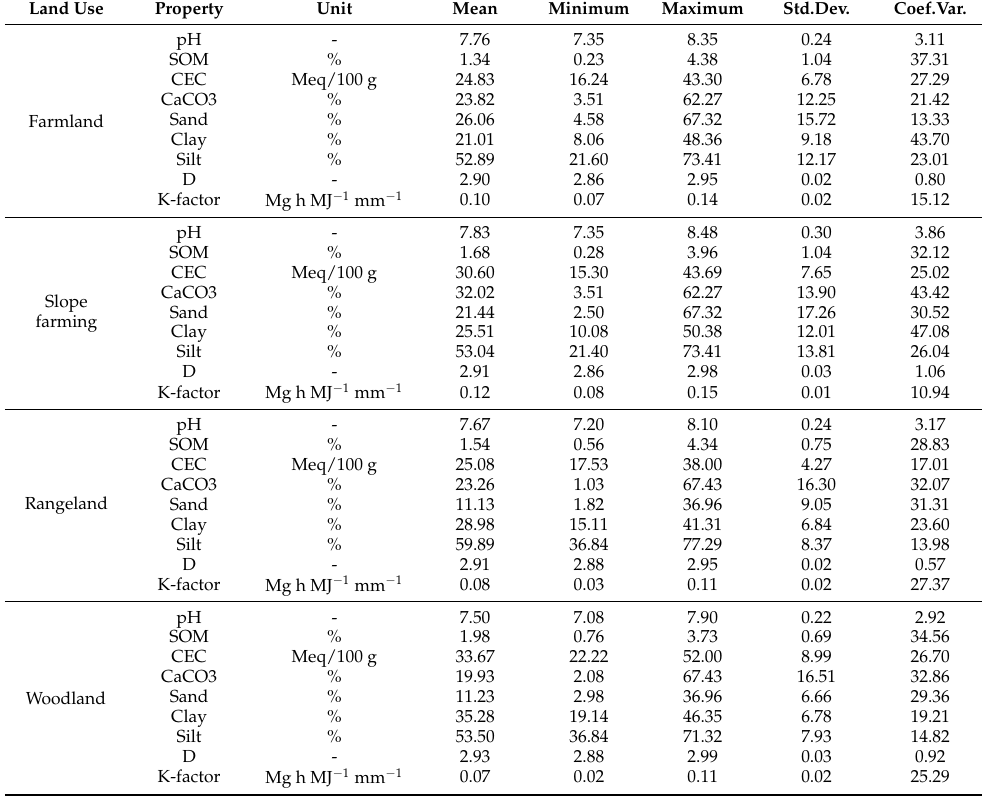
Table 1. Soil property summary statistics ( n =